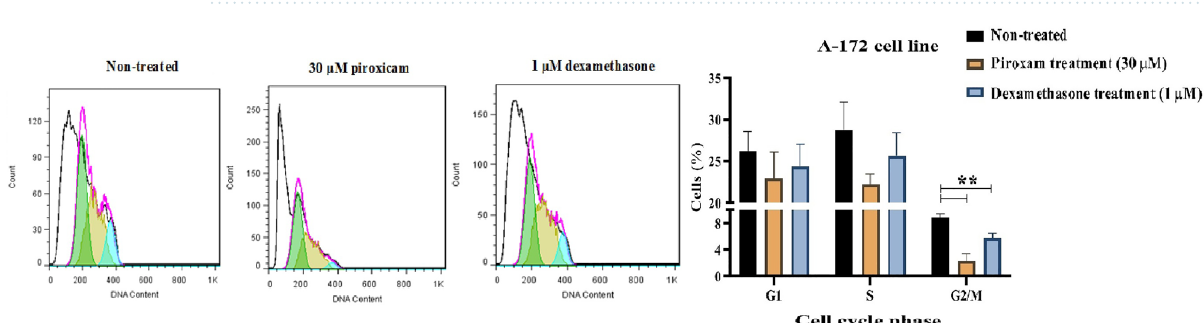
Figure 4. The effect of drugs on the cell cycle phase of T cells in PBMCs. The effect of dexamethasone and piroxicam was measured on the cell cycle phase of T cells in non-treated PBMCs, PBMCs treated with 30 μM piroxicam or with 1 μM dexamethasone (n = 3). The graphs show the mean ± SD. Significant changes are indicated with asterisk (* p < 0.05, ** p < 0.01, *** p < 0.001, **** p < 0.0001).